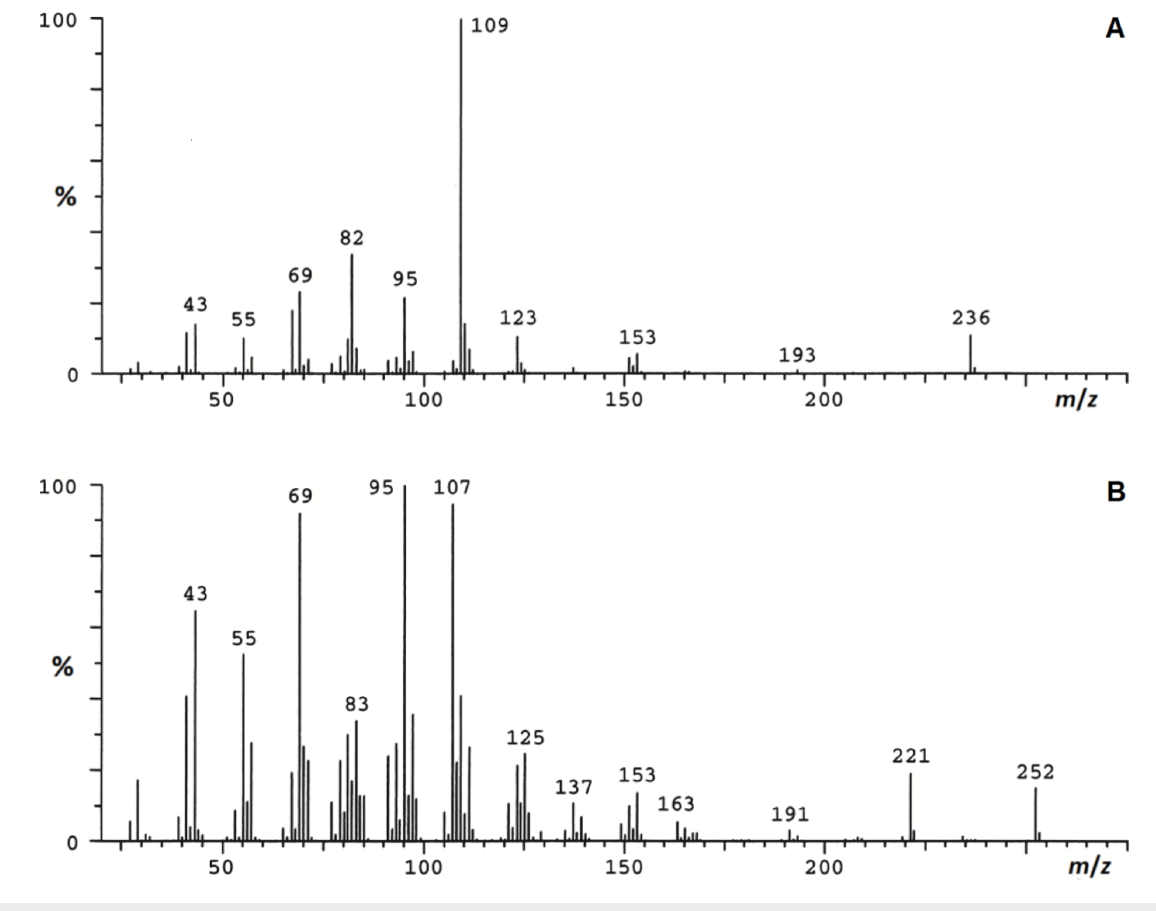
Figure 1: Published 70 eV EI mass spectra of the naturally occurring compounds A and B